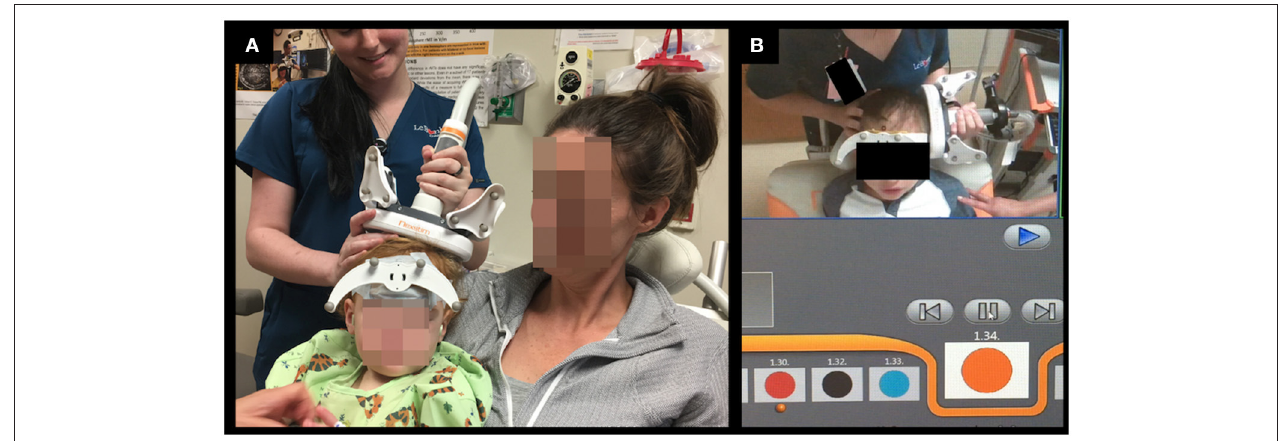
FIGURE 1 | Setup for TMS motor (A) and language (B) mapping studies in young children. (A) : During TMS motor mapping in infants and toddlers, the child is seated on the parent’s lap. (B) : During TMS language mapping color naming task was used in some preschool